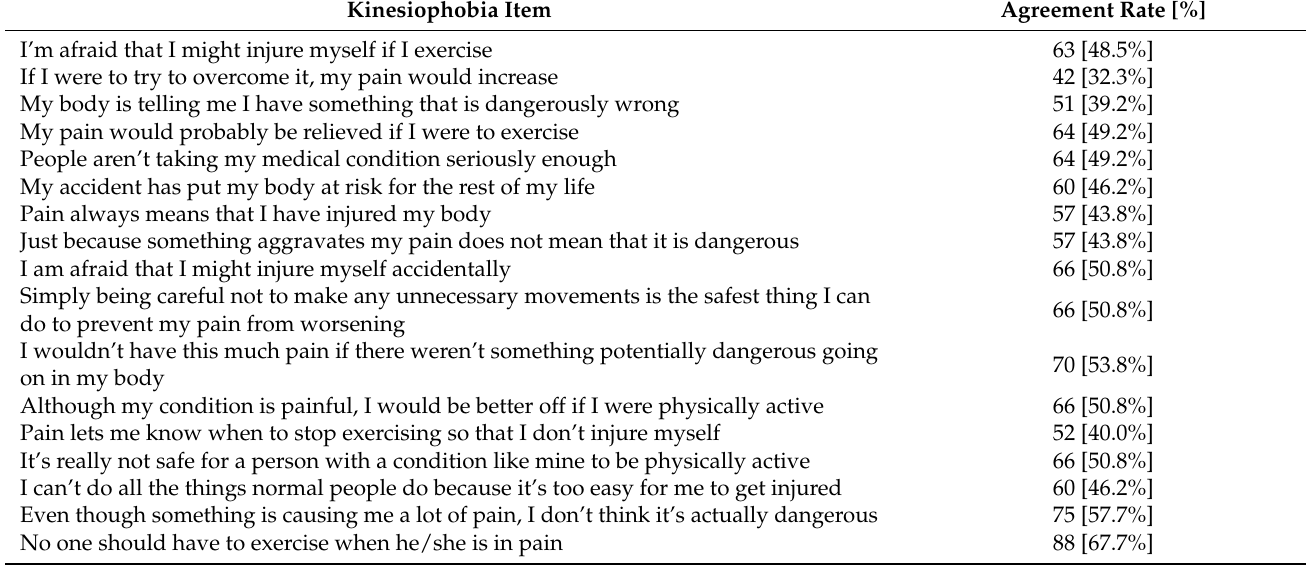
Table 3. Agreement rate for different items of kinesiophobia among patients undergoing ACL reconstruction in Aseer Central Hospital, Saudi